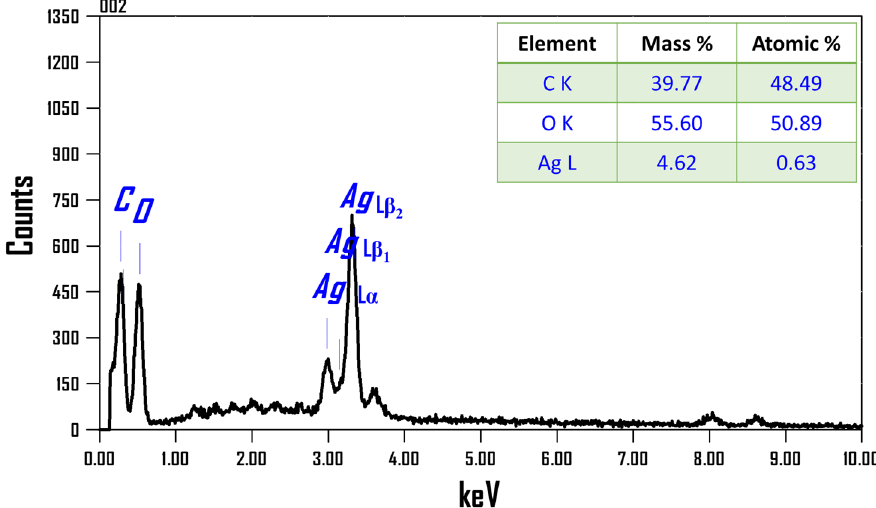
Figure 6. EDX pattern of the GC-capped Ag NPs with their elemental composition percentages. The XRD patterns of the green coffee powder and GC-capped Ag NPs were obtained using a Philips X’Pert Pro MRD. The crystallinity nature and phase composition of metal- lic nanoparticles are key factors affecting their proper catalytic and biological functions.